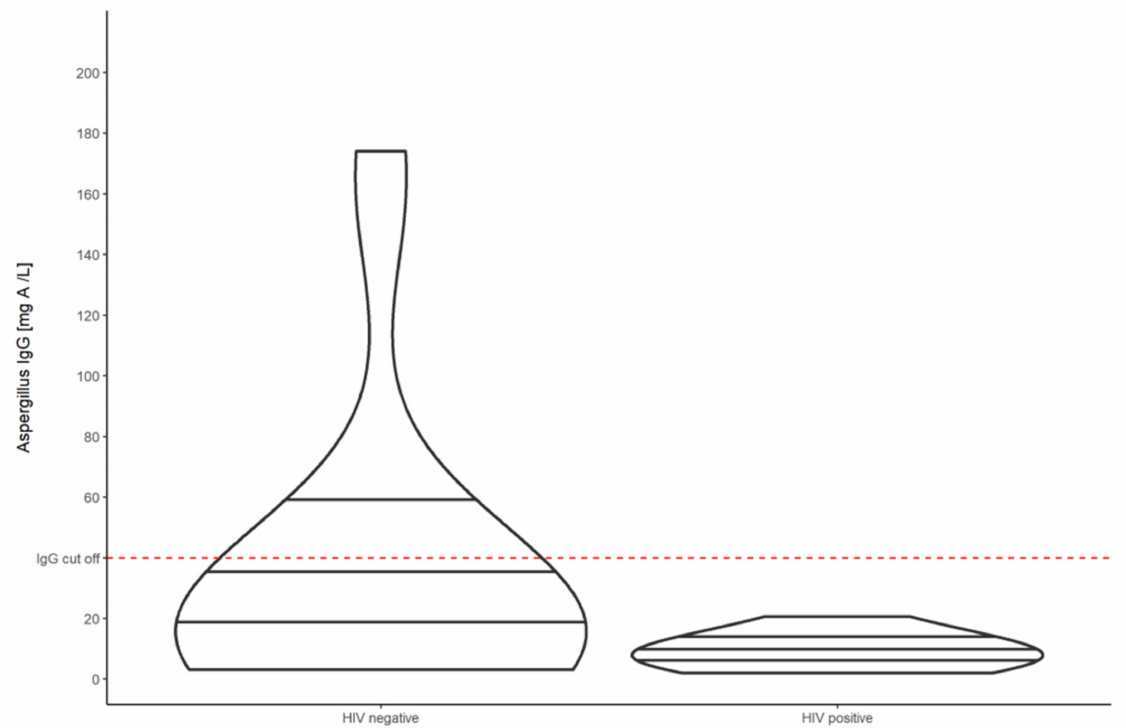
Figure 3. Violin plots showing the Aspergillus -specific IgG antibody levels of HIV-negative compared to HIV-positive patients with pulmonary tuberculosis at week